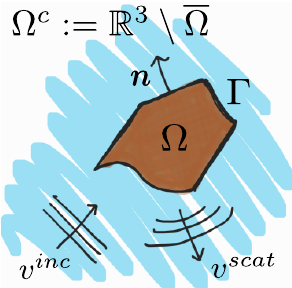
Figure 1. Schematic of the wave scattering problem. The interface between the solid and the fluid is denoted by Γ , while the outward-pointing normal vector (that is defined for almost every point in the boundary) is denoted by n